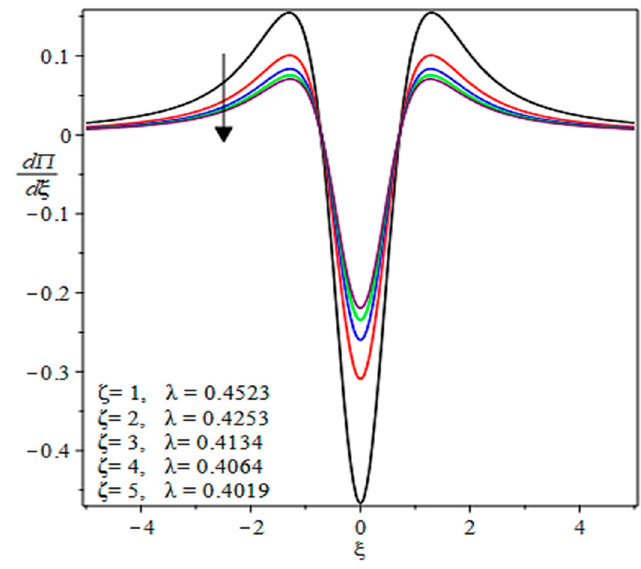
Figure 12. MHD parameter M influence on the pressure gradient by fixing K = 0.1, ζ = 2.